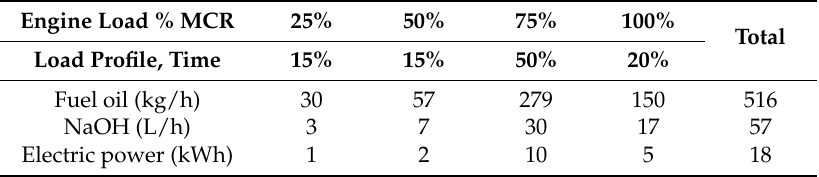
Table 4. Absolute consumption according to the load profile.